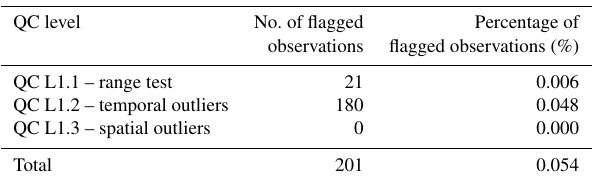
Table 10. Number and percentage of observations flagged as out- liers during QC level